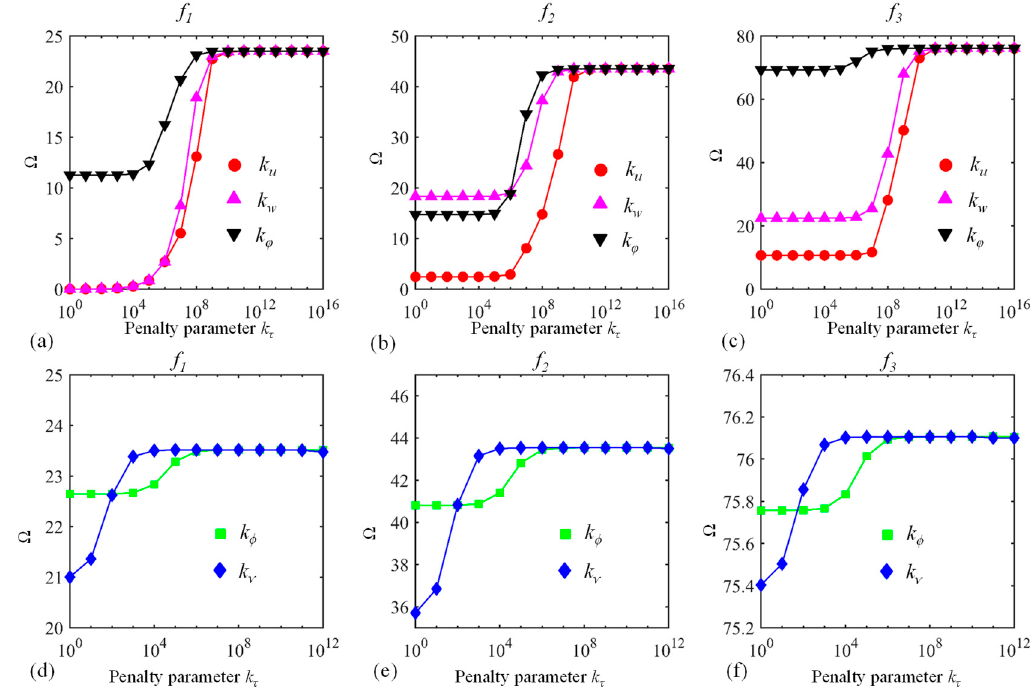
( ) τ ϕ and ( d – f ) = , , k u w τ